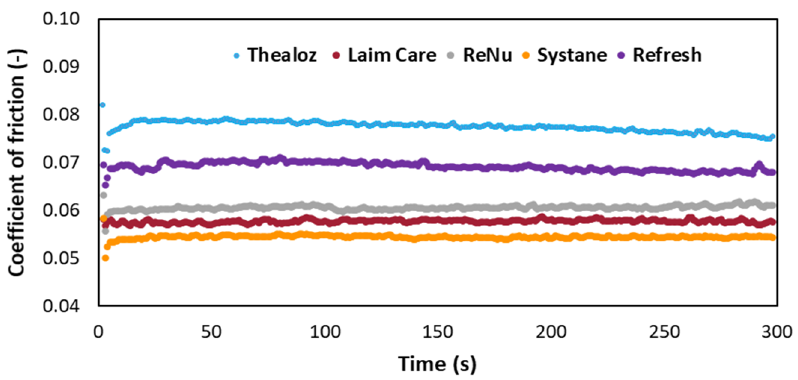
Figure 4. Friction coefficient dependence on time for five commercial eye drops.